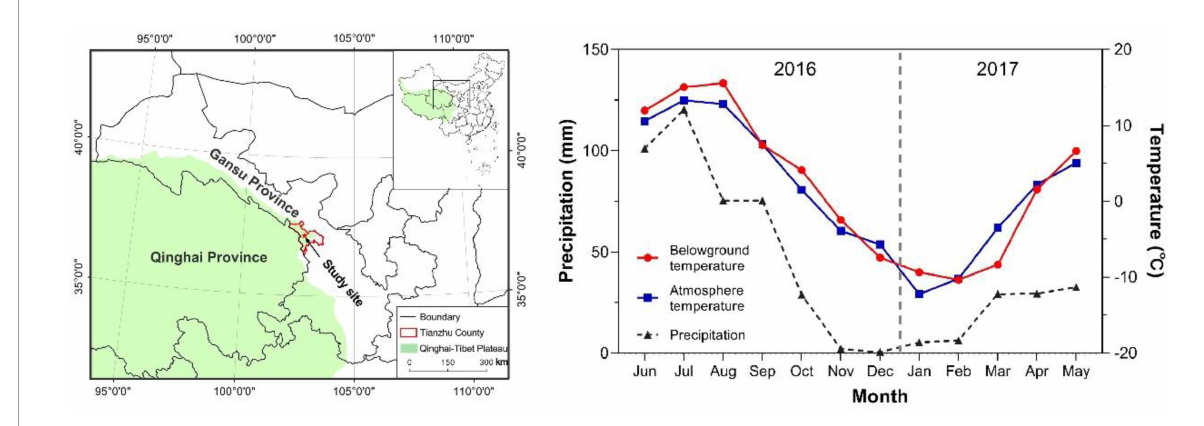
FIGURE1 (Left-hand panel) Location of the study site. (Right-hand panel) Changes in temperature (air and 15 cm underground) and precipitation from June 2016 to May 2017.